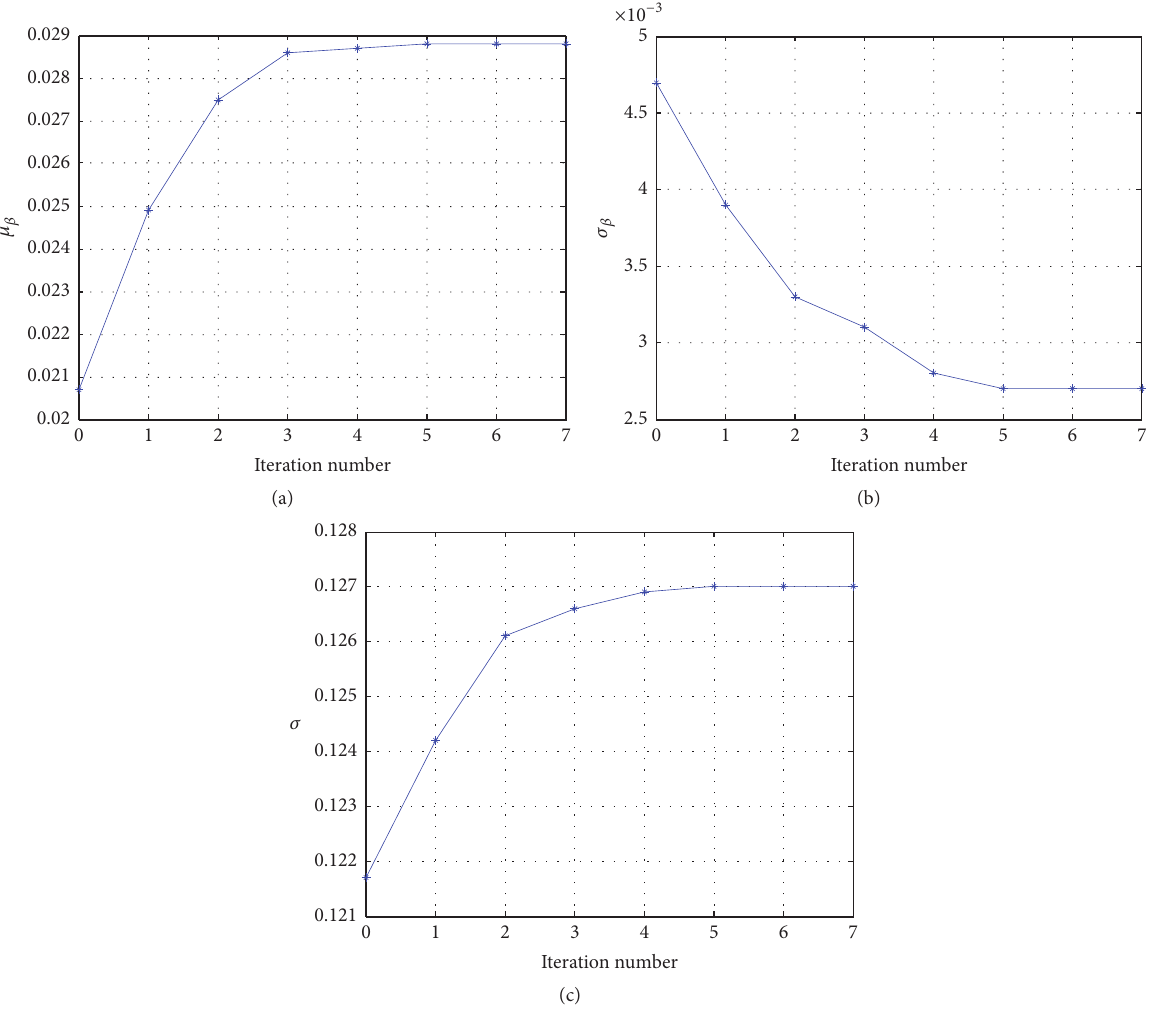
over four iterations: ̂𝜇 𝛽 = 0.0288 , ̂𝜎 𝛽 = 0.0027 , and ̂𝜎 = 0.1270